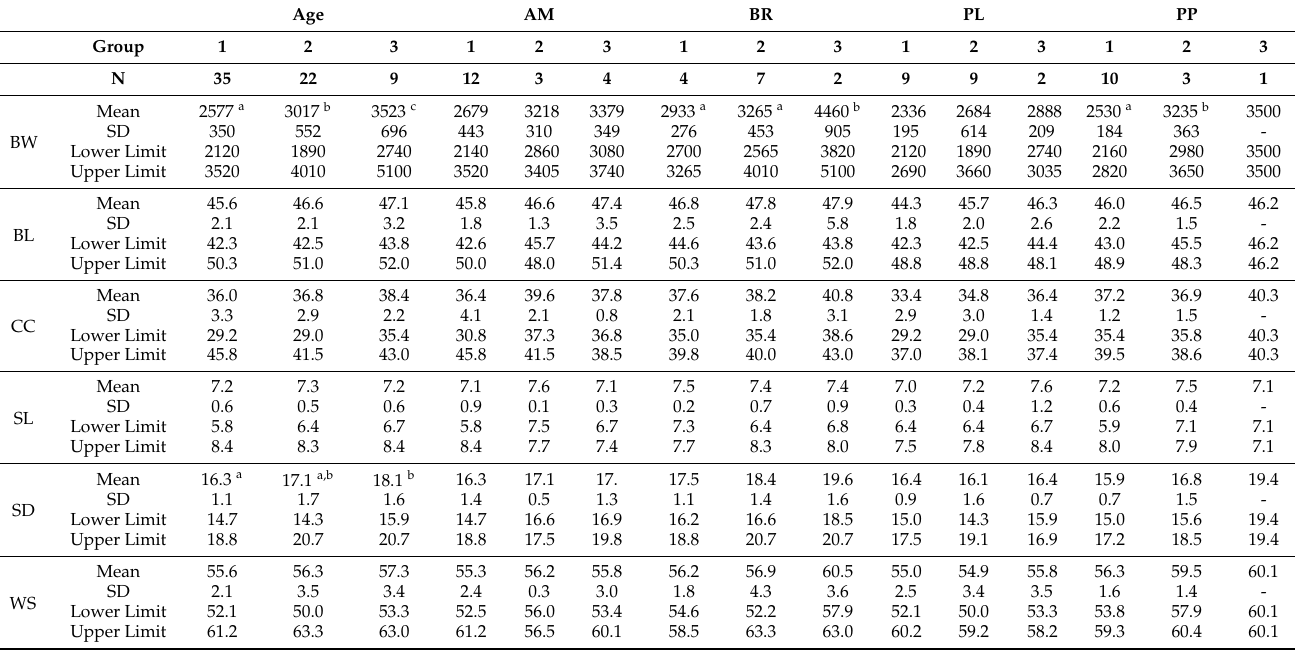
Table 3. Effects of age group and breed in the different zoometric measures (cm) and body weight (g) in roosters. Age AM BR PL